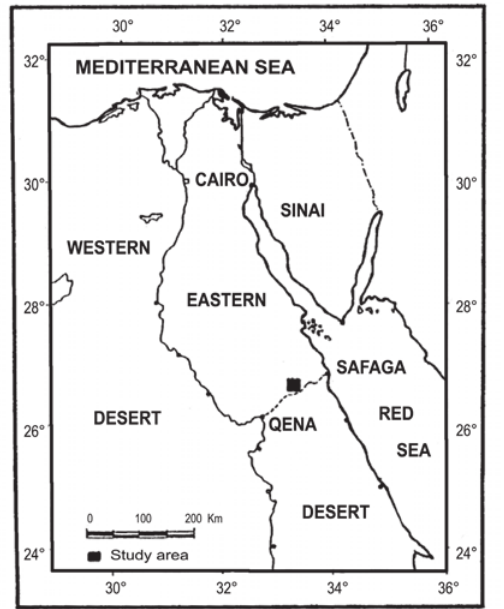
Fig. 1. Key map showing the location of the Abu- Shihat radioactive prospect area, North Eastern Desert,